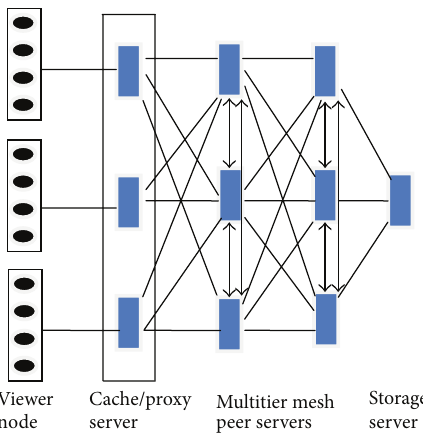
Figure 2: Distributed hybrid